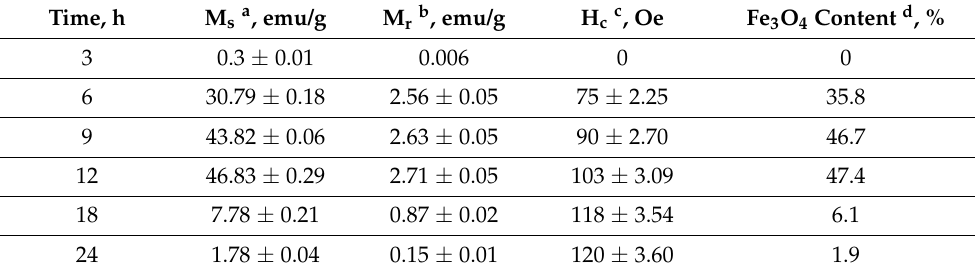
Table 4. Magnetic properties of obtained iron oxide and oxyhydroxide